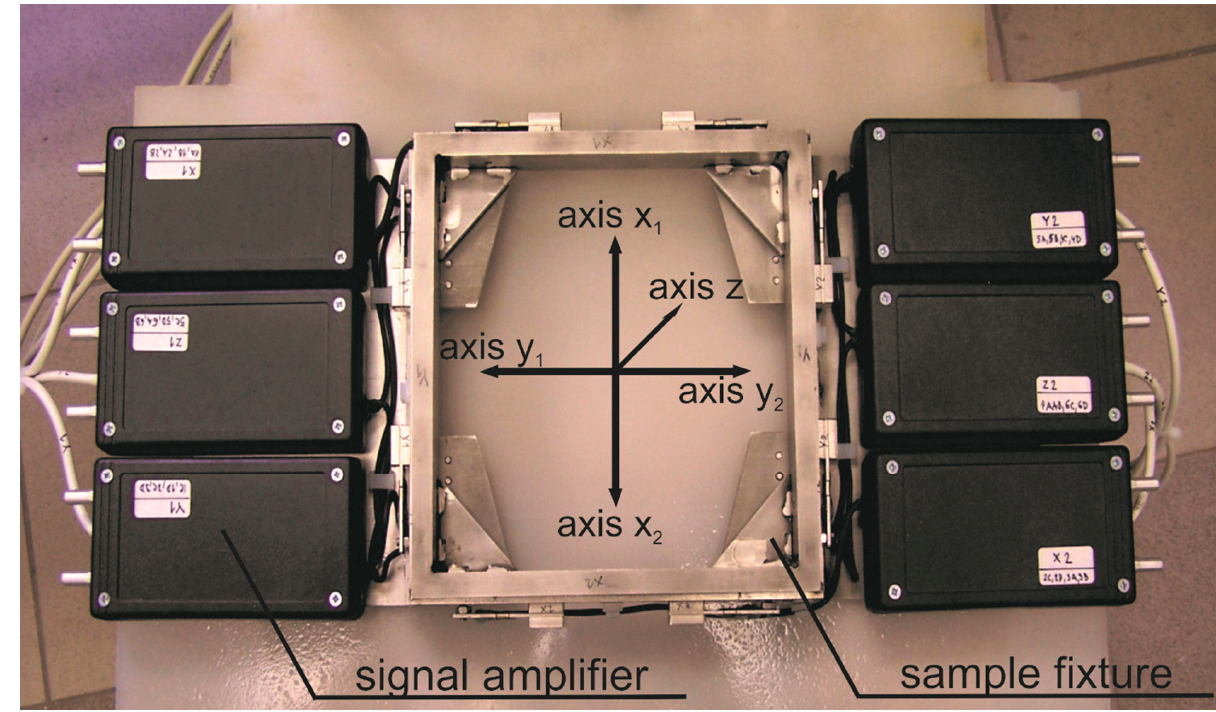
Figure 2. Force sensor designed and constructed for abrasive waterjet (AWJ) force measurements (amplifiers for strain gauges are closed in black boxes being blown through by pressurized air to prevent moisture).